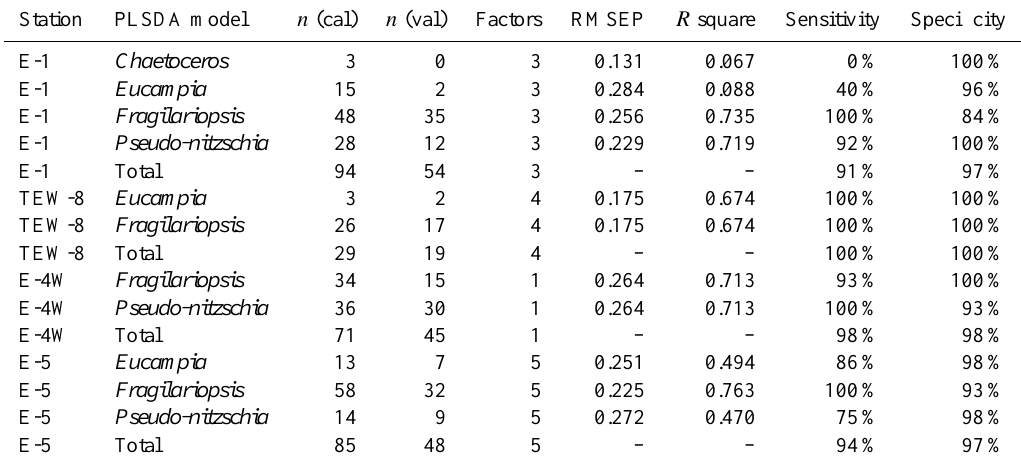
Table 3. Taxonomic classification summary statistics for PLSDA